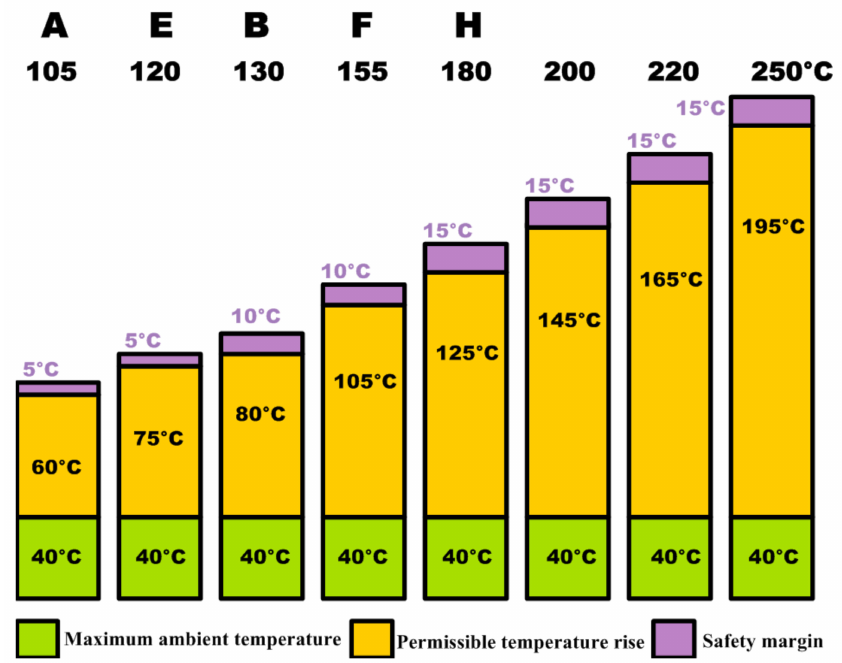
Figure 12. Classification of the electrical insulation materials based on their upper temperature limit [IEC standard